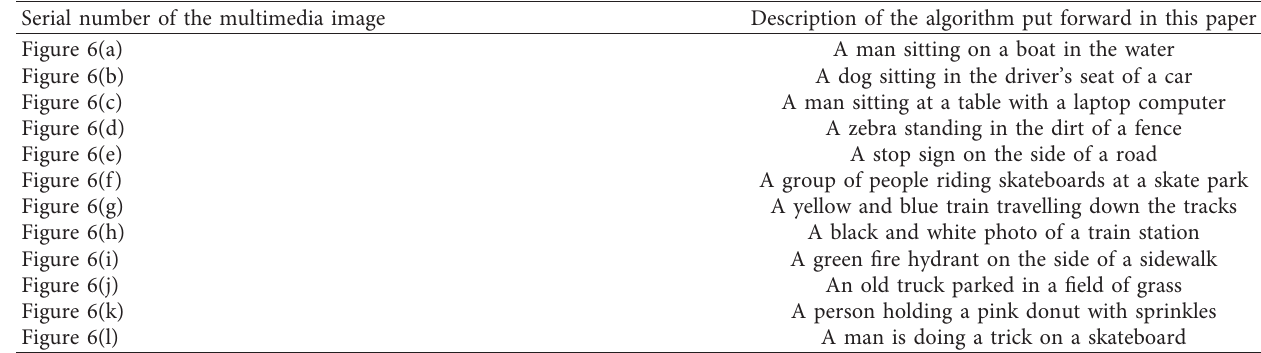
Table 5: Descriptive effect of the algorithm put forward in this paper in the test of multimedia image. Serial number of the multimedia